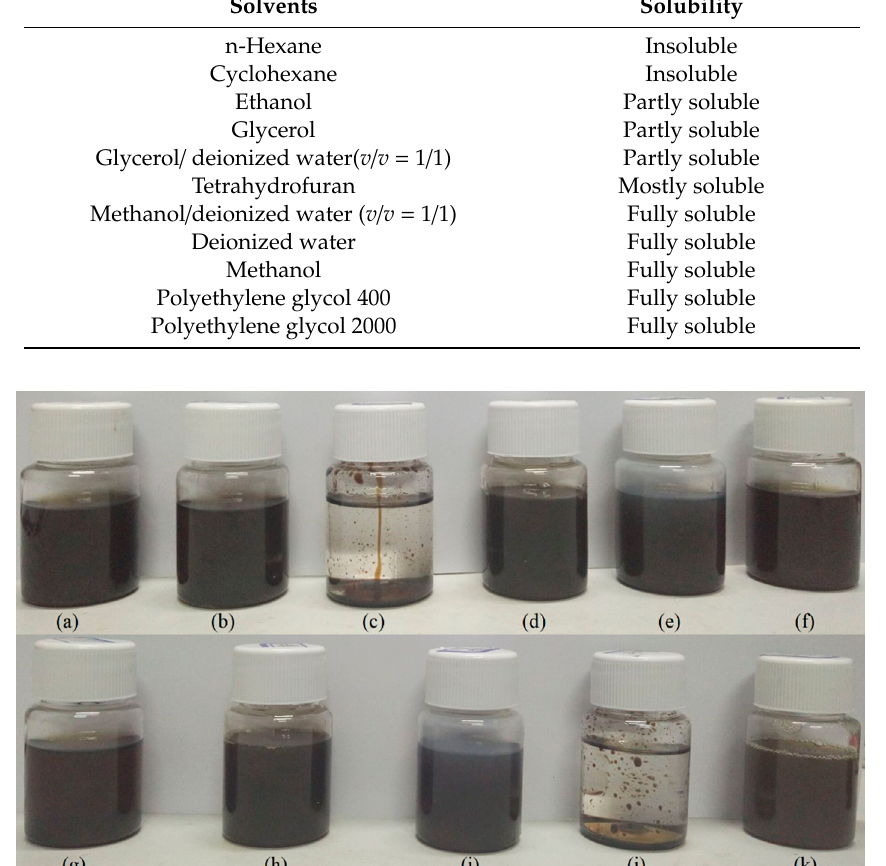
Figure 2. The solubility of liquefied products in common solvents: ( a ) tetrahydrofuran, ( b ) ethanol, ( c ) cyclohexane, ( d ) methanol, ( e ) deionized water, ( f ) glycerol, ( g ) glycerol/ deionized water (v/v = 1/1), ( h ) PEG 2000, ( i ) PEG 400, ( j ) n-Hexane, ( k ) methanol/deionized water (v/v = 1/1). Table 2. Solubility of liquefied products in conventional solvents.